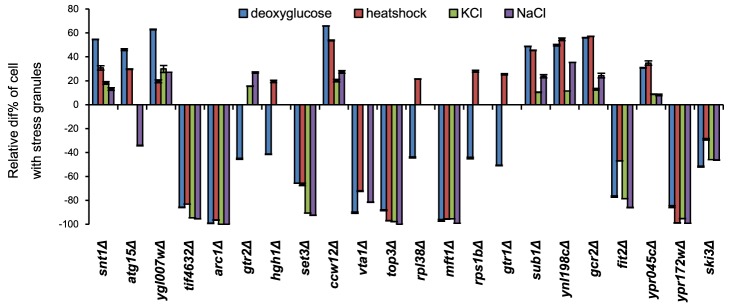
SG phenotypes of individual mutants are mostly general for different stress types.The indicated mutant cells were exposed to the following stress conditions: 400 mM 2-DG (90 min); 44°C (45 min); 1.5 M KCl (90 min); 1.5 M NaCl (90 min). SG phenotype is shown as the deviation from wt level (his3Δ) scaled as in Fig. 1 C. Error bars indicate standard error for 25 independent determinations (about 80 cells per image) for each data point.